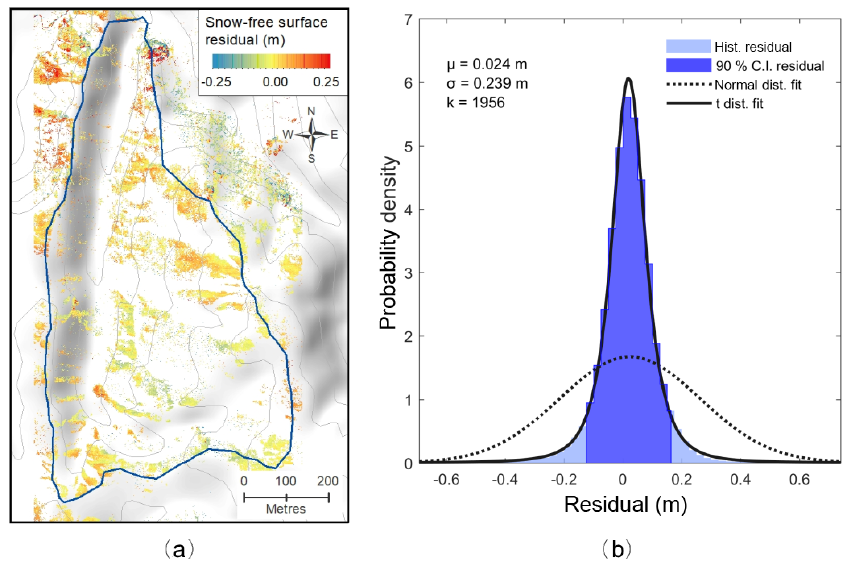
Figure 5. Map (a) and histogram (b) of the vertical residual for snow-free areas for surface models derived from the autumn and spring flights. The histogram includes fitted normal and t location-scale ( t )